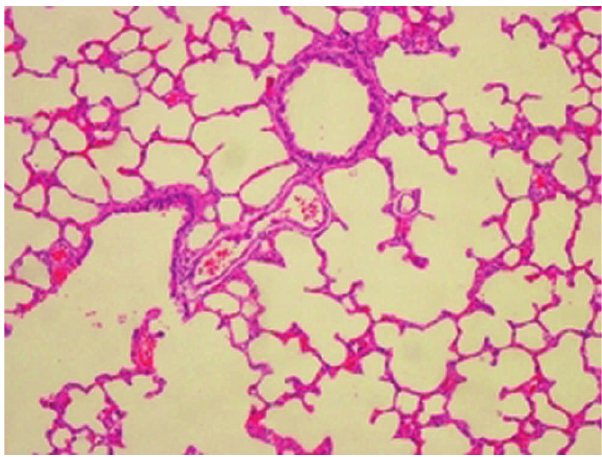
Figure 2 - Histopathological findings in the control group (Group I). No abnormalities were found (H&E, 6